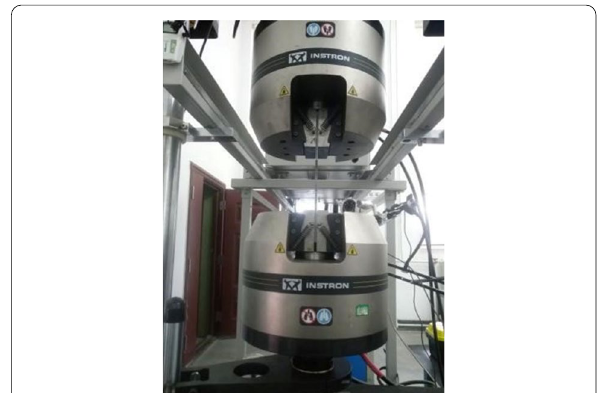
Figure 21 Fatigue test of butt weld